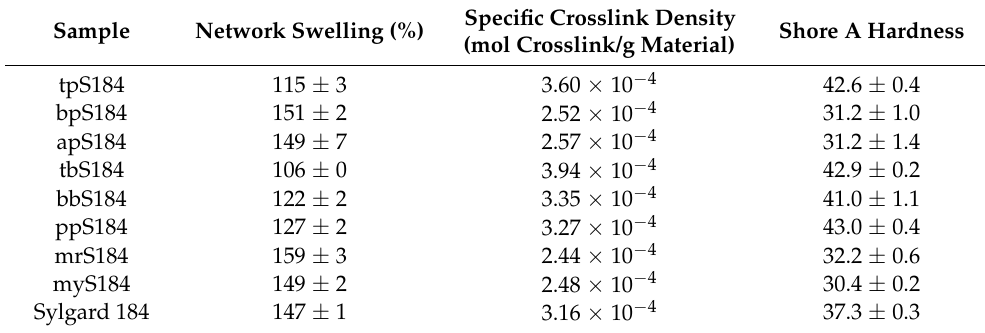
Table 3. Solvent swelling properties and Shore A Hardness of the 0.5 wt.% composite chromophoric sensors compared to Syglard